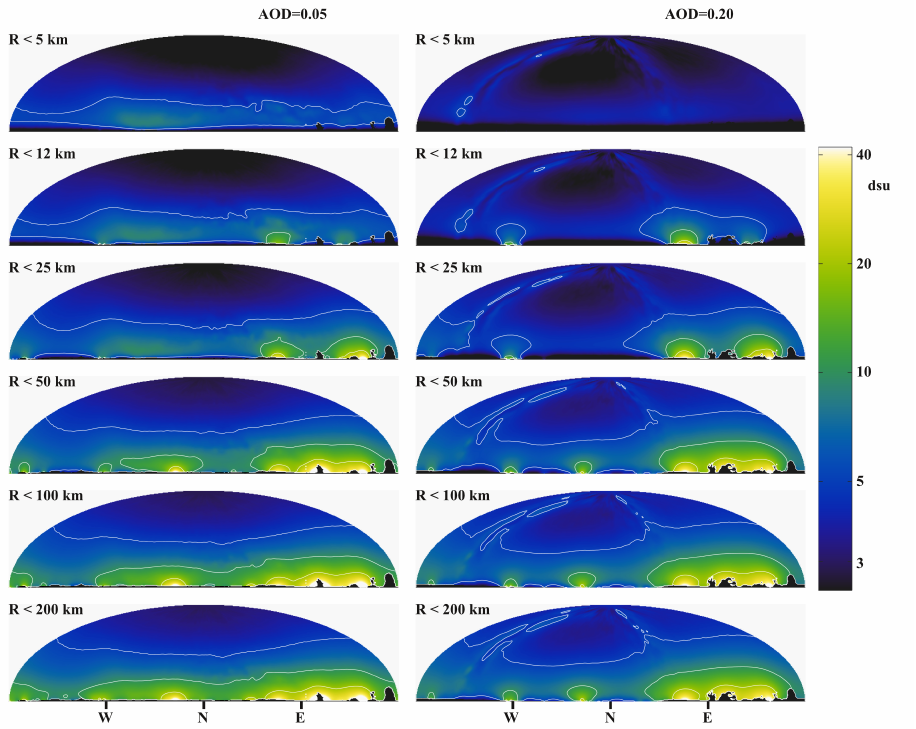
Figure 11. The build-up of the sky radiance vs the distance of included sources. The aerosol optical depth (AOD) used for the Monte Carlo simulation is indicated at the top of the figure. The maximum distance of the used sources is displayed at each